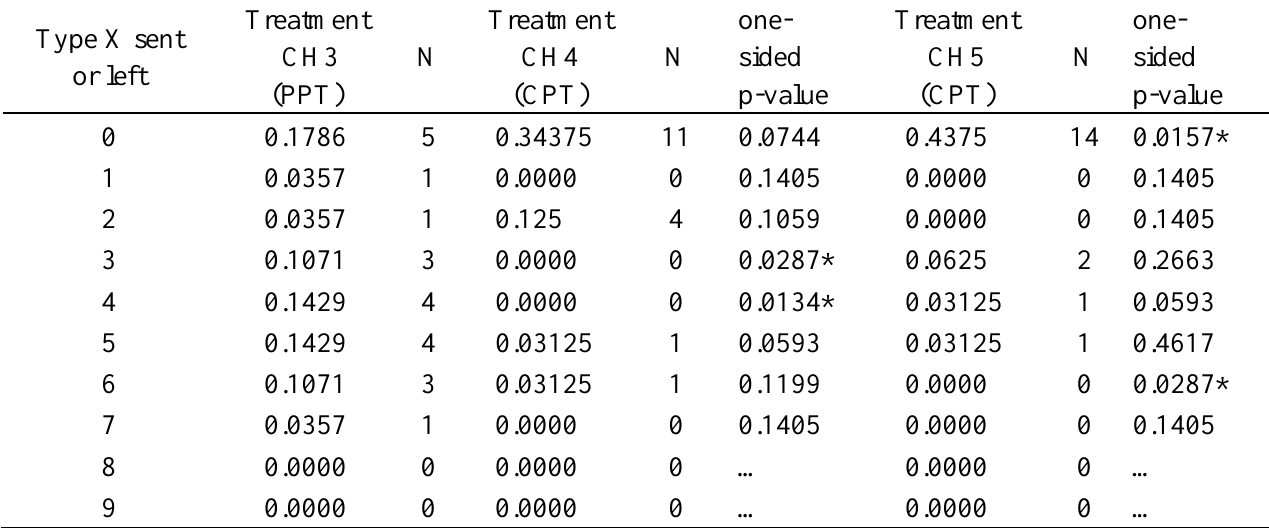
Table A6. Proportions tests of Type X data for CH3 and (non-pooled) CH4 and